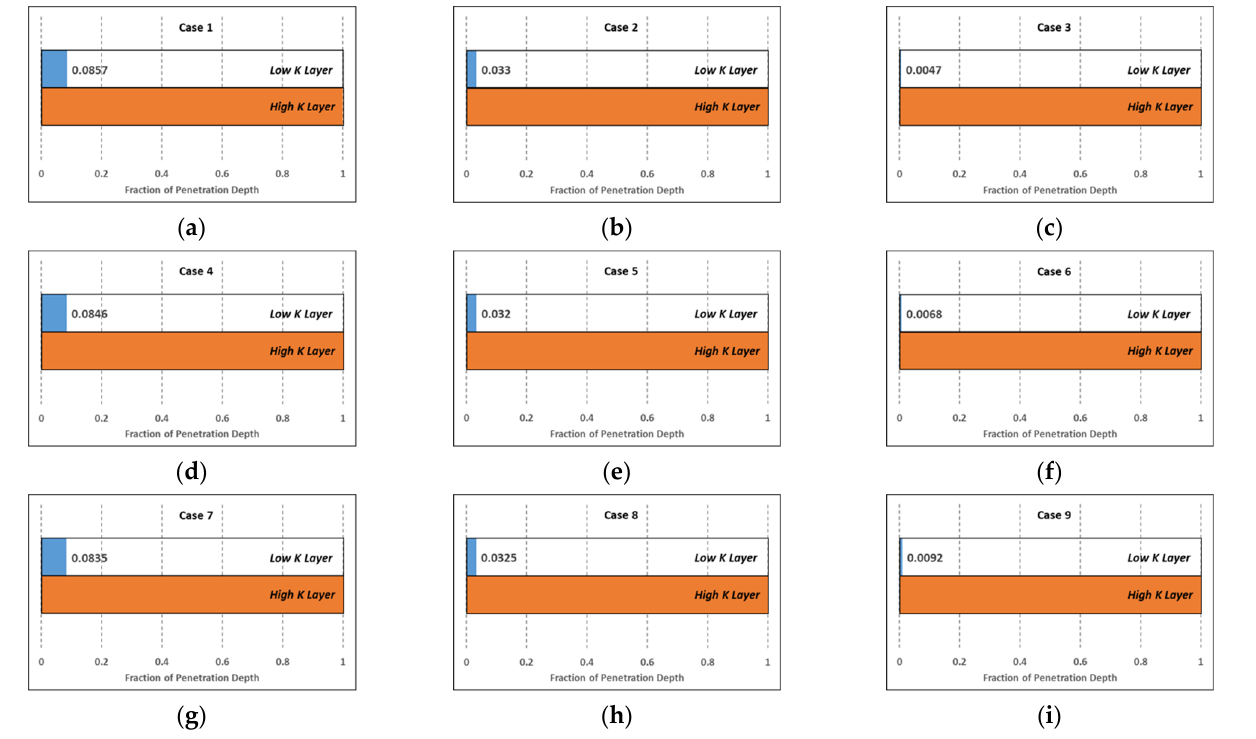
Figure 11. Gelant placement results in the low k and high k layers in the new IAPV model (sub-figure ( a – i ) corresponding to Cases 1–9).